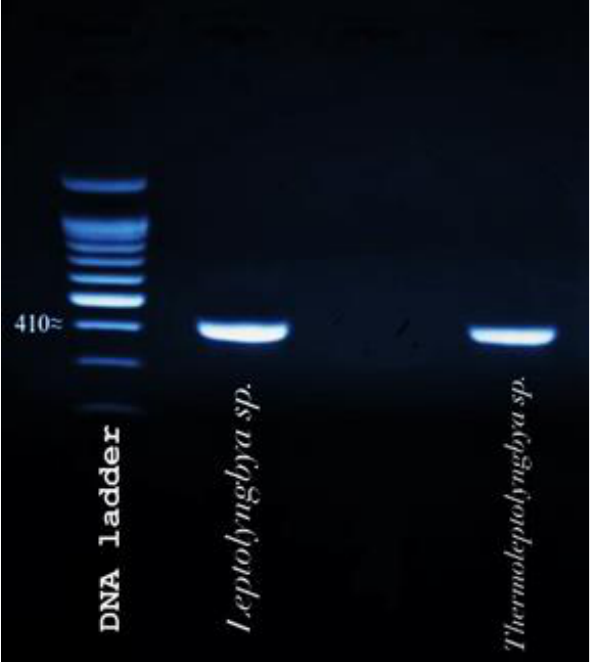
Figure 1. PCR products of the partial 23S rDNA amplification .